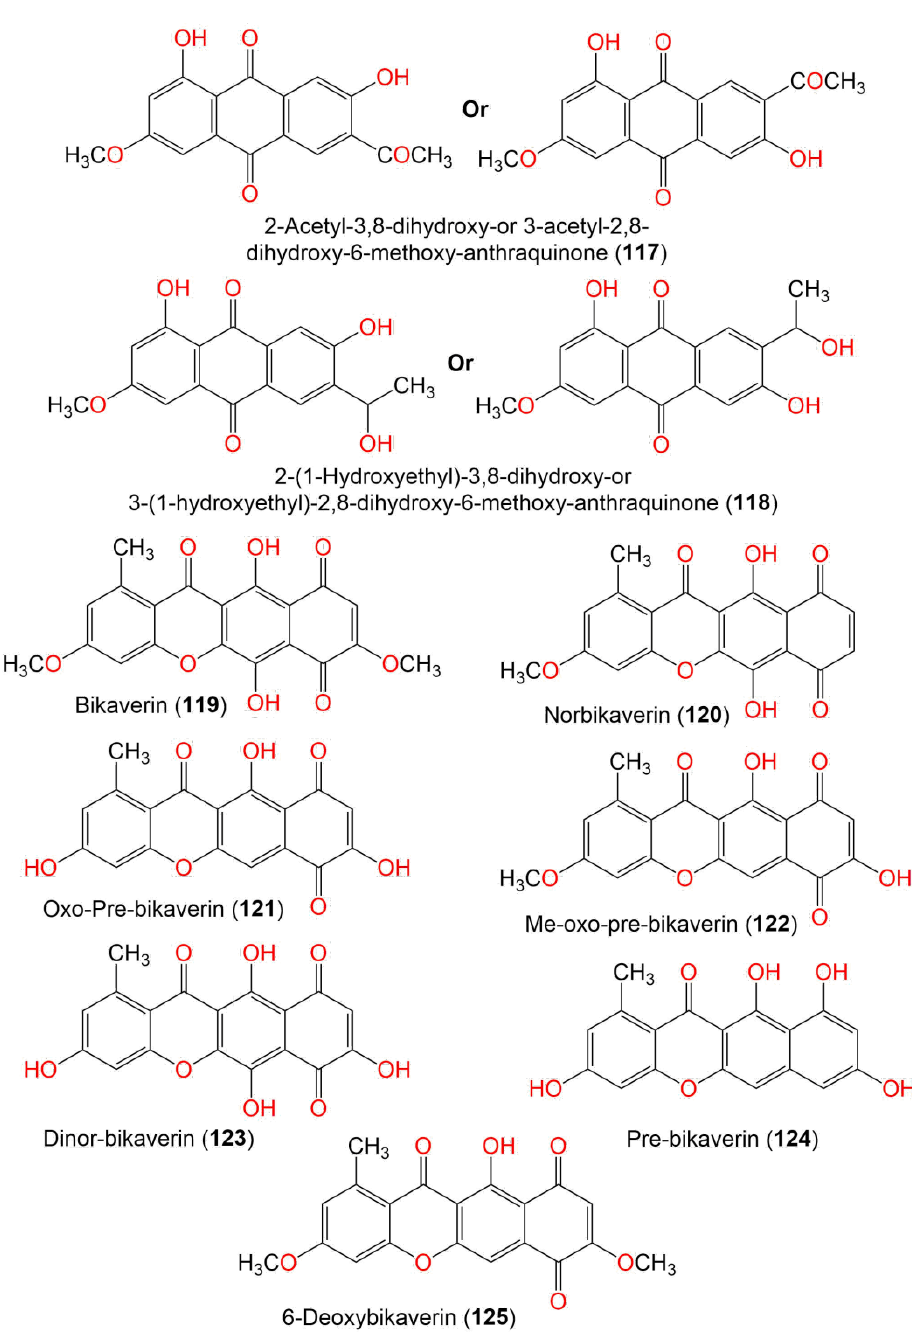
Figure 13. Structures of xanthone derivatives ( 117 – 125 ) isolated from F. oxysporum .